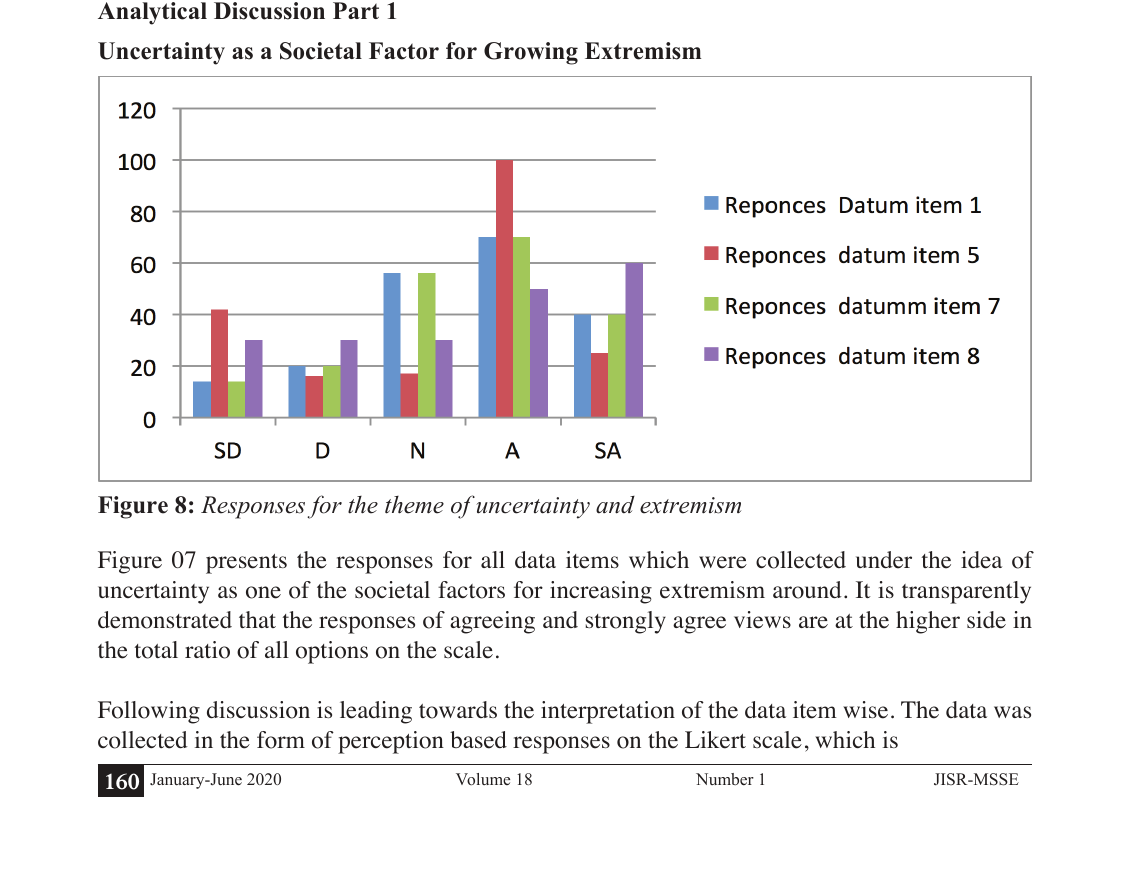
Analytical Discussion Part